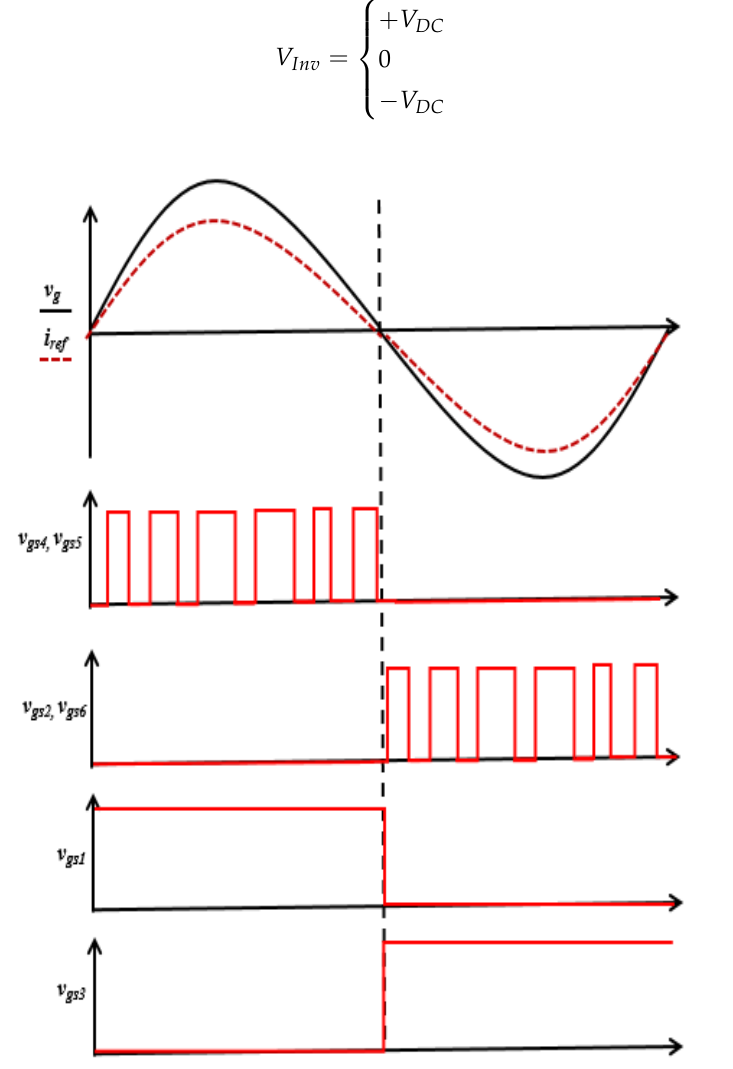
Figure 3. Gate drive signals with unity power